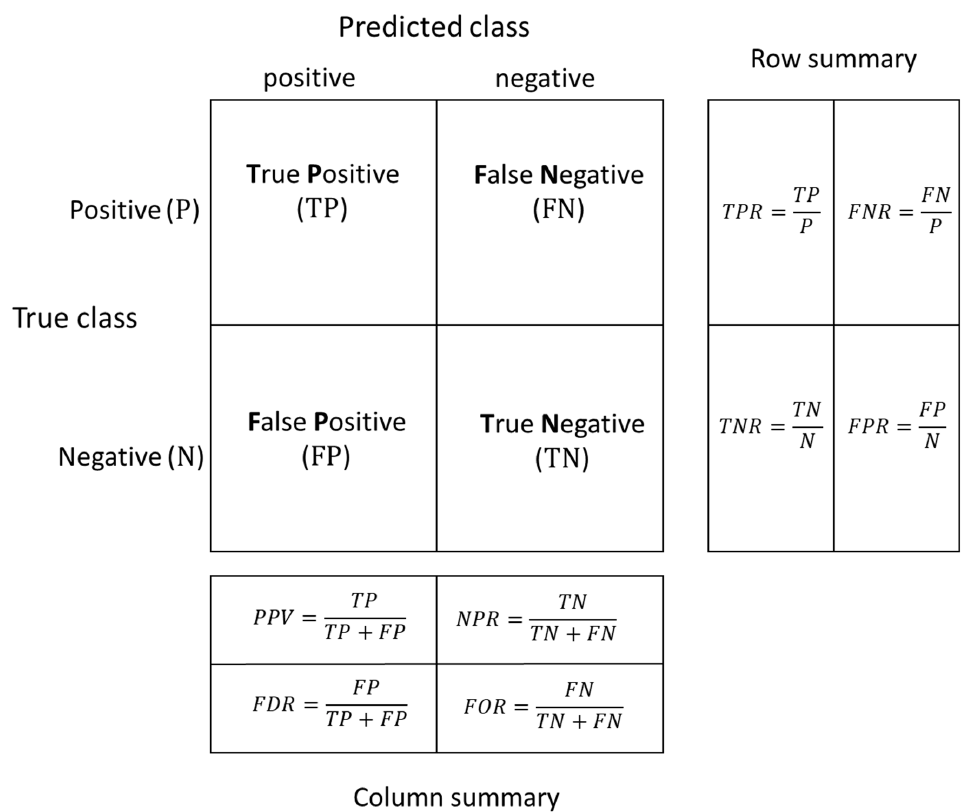
Figure 4. A concept diagram of a confusion matrix can be used for evaluating the model prediction. True class is the original labeled class, and the predicted class is the model predicted class. Row summary displays the percentages of correctly and incorrectly classified data for each true class. The column summary displays the percentages of correctly and incorrectly classified data for each predicted